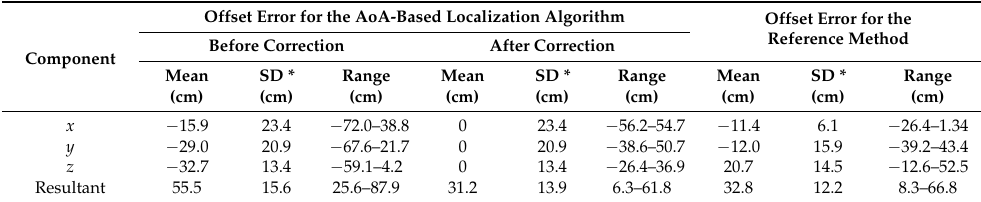
Table 3. Characteristics of the experimental results of the offset error for the 36 spatial location samples for the AoA-based localization algorithm before and after correction and the reference algorithm for LS’s AB pair.